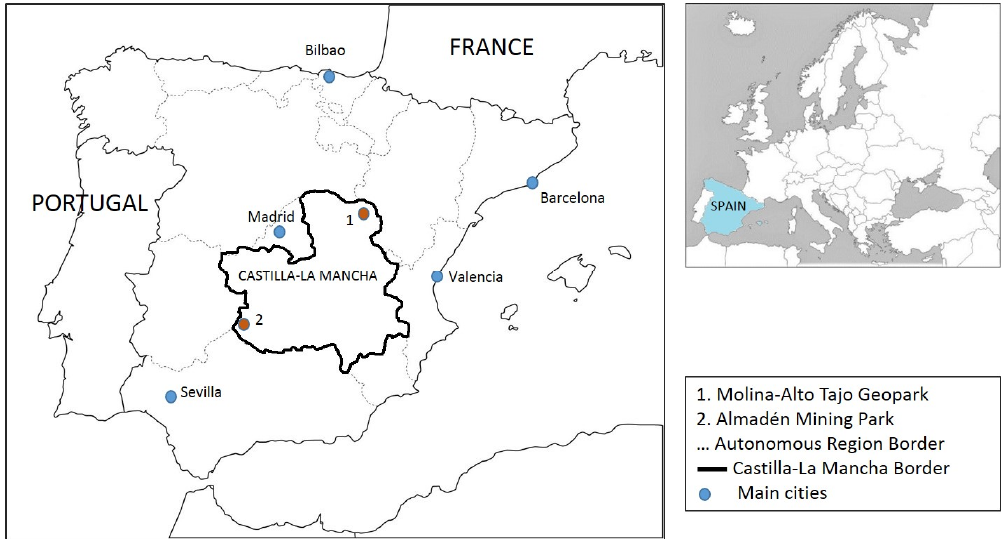
Figure 1. Location of the case studies. Created by the authors.